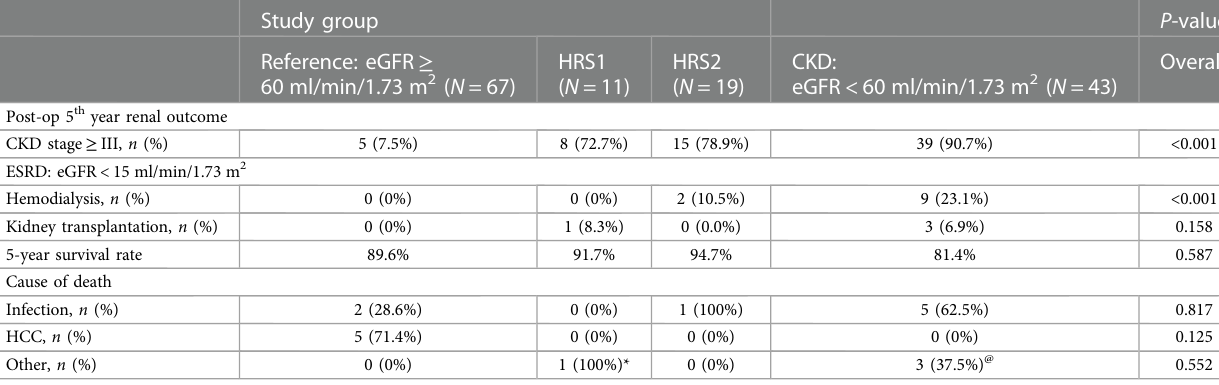
TABLE 5 Post-LDLT 5th year renal outcome in four groups strati fi ed by preoperative renal function. Study